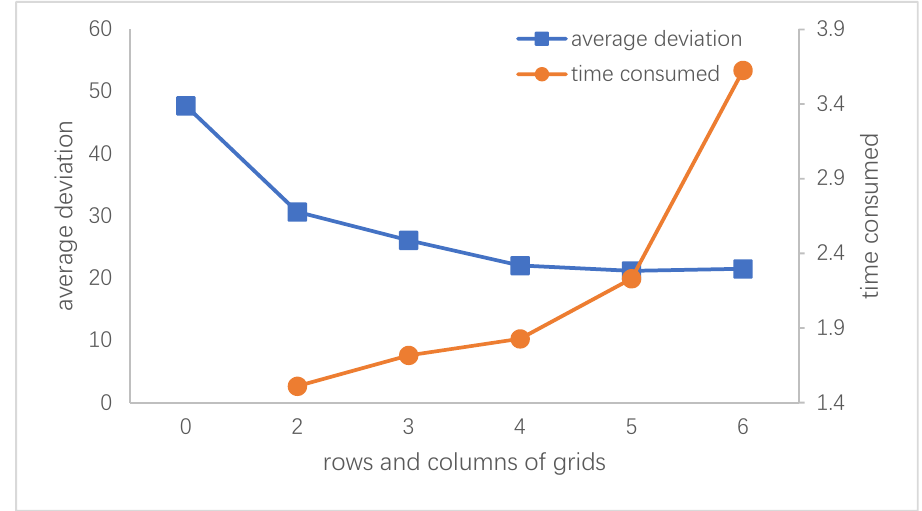
Figure 7. The influence of grid number. 0 grids represent the result of rough registration.